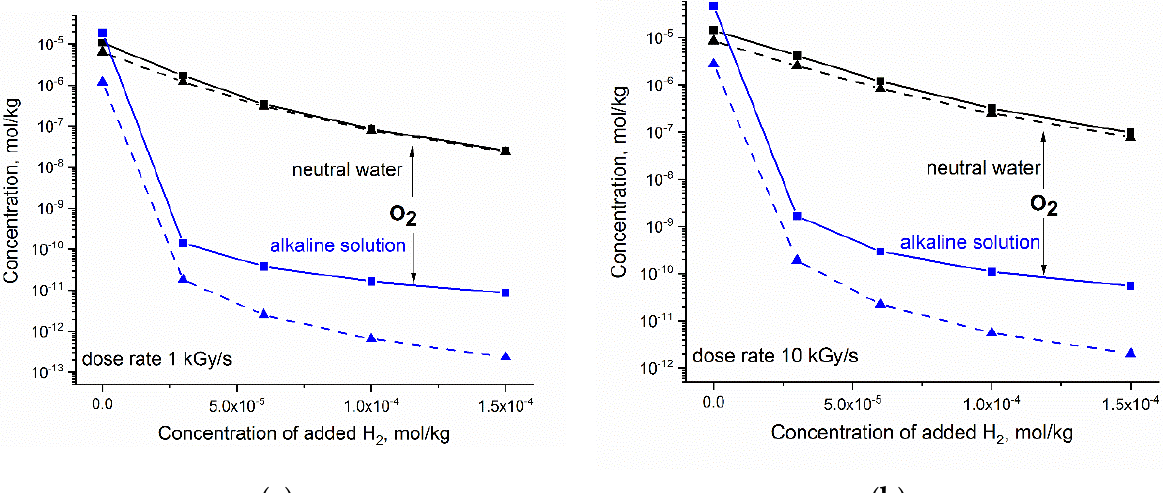
Figure 5. Simulated response of the steady state concentration of O 2 to hydrogen added to neutral water at 300 °C (black) and to alkaline solution containing 2·10 − 4 mol kg − 1 OH − ions (blue): ( a ) dose rate 1 kGy·s − 1 ; ( b ) dose rate 10 kGy·s − 1 . Solid and dashed lines refer to fast neutron and gamma radiolysis, respectively.